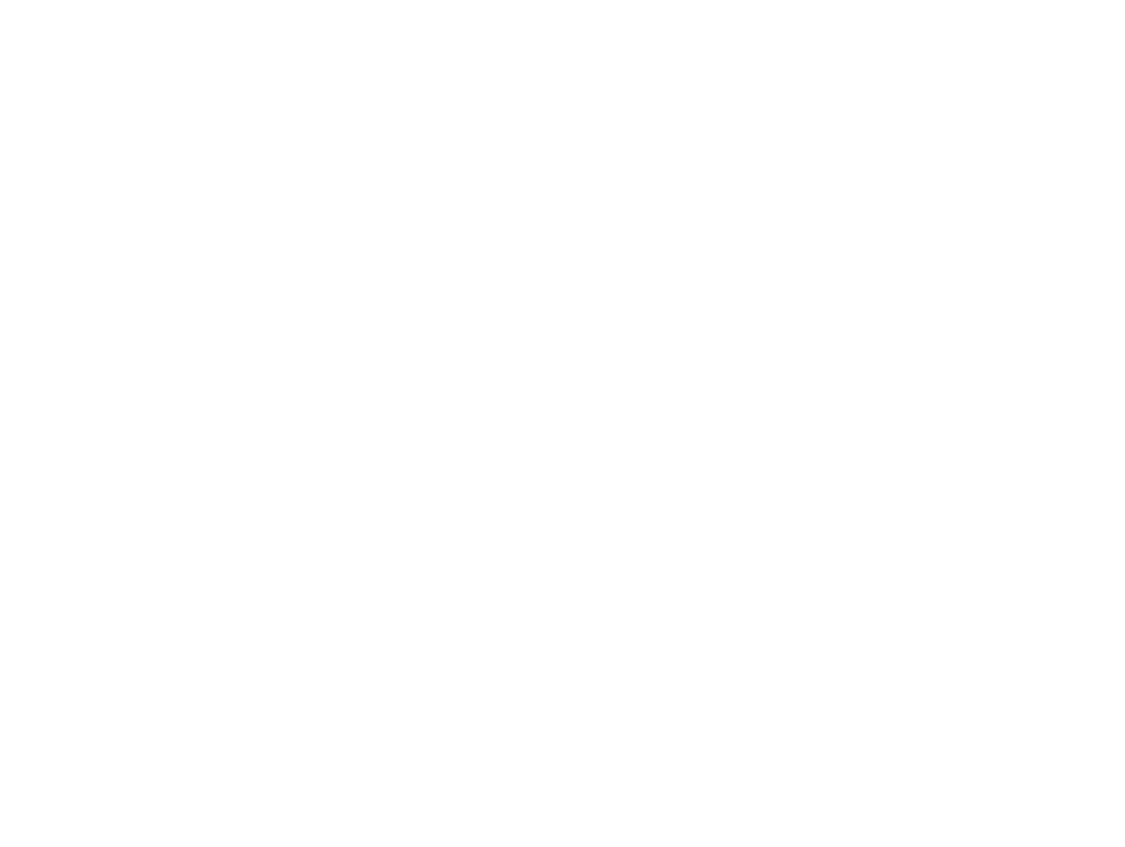
Warnings regarding use during critical period